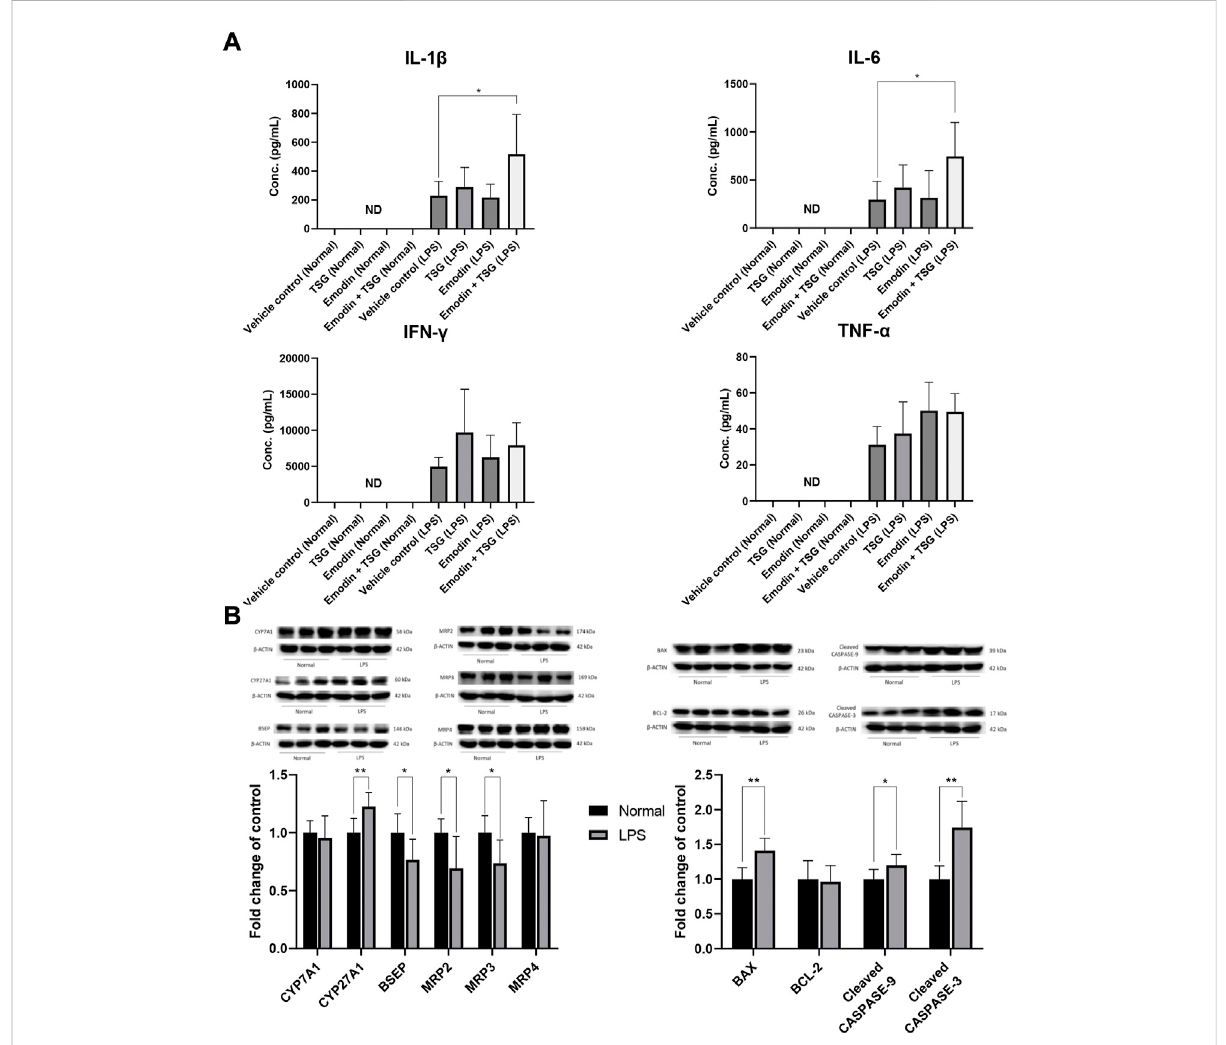
FIGURE 2 Plasma levels of the in fl ammatory cytokines after oral administrations of vehicle control, TSG, emodin and their combination to normal rats (Normal) and LPS-mediated in fl ammatory stress model rats (LPS), * p < 0.05 by two-way ANOVA followed by the Tukey post hoc test, ND, not detectable (A) ; protein expression of bile acid synthesis enzymes (CYP7A1, CYP27A1), ef fl ux transporters (BSEP, MRP2, MRP3, MRP4) and apoptosis- related proteins (BAX, BCL-2, Cleaved CASPASE-9, Cleaved CASPASE-3) in the liver after oral administration with vehicle control to normal